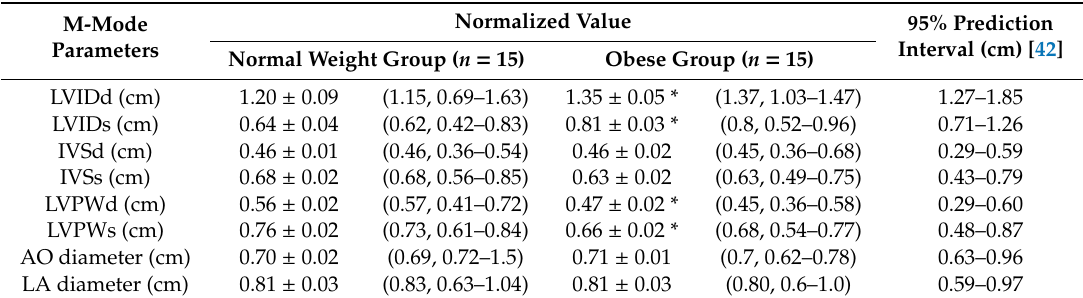
Table 3. Normalization with body weight of M-mode parameters in normal weight and obese groups. Mean ± SE (median, minimum–maximum) are